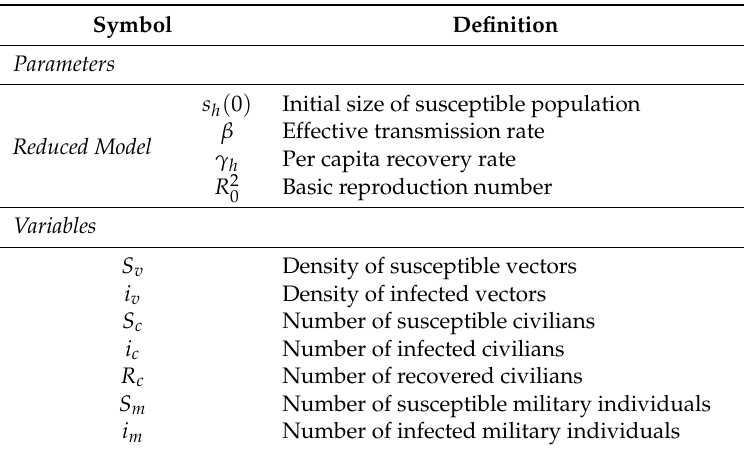
Figure 5. Flow chart representing the mathematical model for Tolima. Table 3 . Variables and parameters of the model used for Tolima, Colombia.